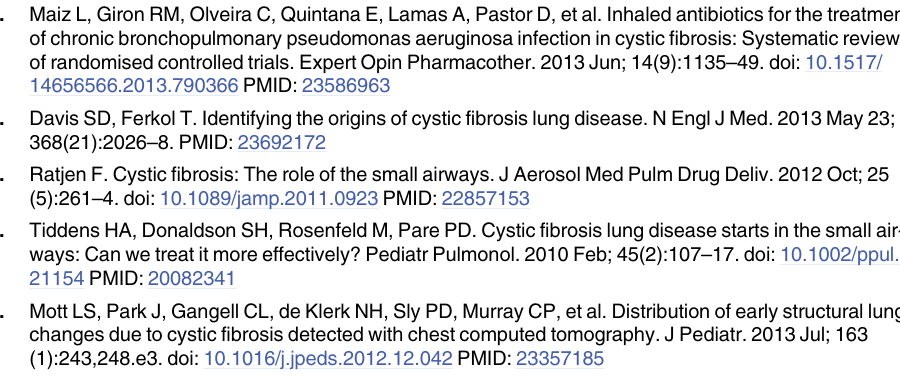
creases in aerosol diameter and increases in airway surface liquid (ASL) thickness on the AZLI concentrations. Data are presented as median (range). In each figure the AZLI concentrations are shown per separate lung lobe for the 3 different sizes of aerosol diameter. White bars repre- sent the smallest aerosol diameter (2.9 μ m), light grey bars represent the median aerosol diame- ter (3.18 μ m) and dark grey bars represent the largest aerosol diameter (4.35 μ m). The separate parts of the figure represent the 3 different thicknesses of ASL. Part S2a shows the AZLI con- centrations calculated for the thin ASL (3 μ m), part S2b shows the AZLI concentrations calcu- lated for the median ASL (5 μ m) and part S2c shows the AZLI concentrations calculated for the thick ASL (7 μ m). RUL = right upper lobe, RML = right middle lobe. RLL = right lower lobe, LUL = left upper lobe, LLL = left lower lobe. The larger the aerosol diameter and the thicker the ASL the lower were the AZLI concentrations. Note differences in the scale on the vertical axes between the 3 separate parts of the figure. S1 Table. P-values of pairwise comparison of AZLI concentrations between lobes, accompa- nying Fig. 3. P-values of comparison between lobes in AZLI concentrations for the scenario of thick lining fluid with largest aerosol diameter. P-values in bold represent significant differ- ences. RUL = right upper lobe, RML = right middle lobe. RLL = right lower lobe, LUL = left upper lobe, LLL = left lower